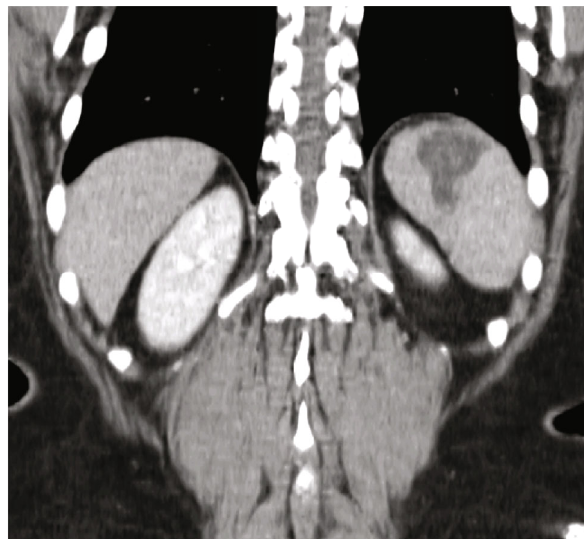
Figure 3: First postoperative CT scan showing an ischemic area of 40 × 40mm in the superior pole of the